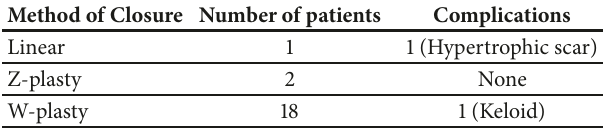
Table 3: Closure types.